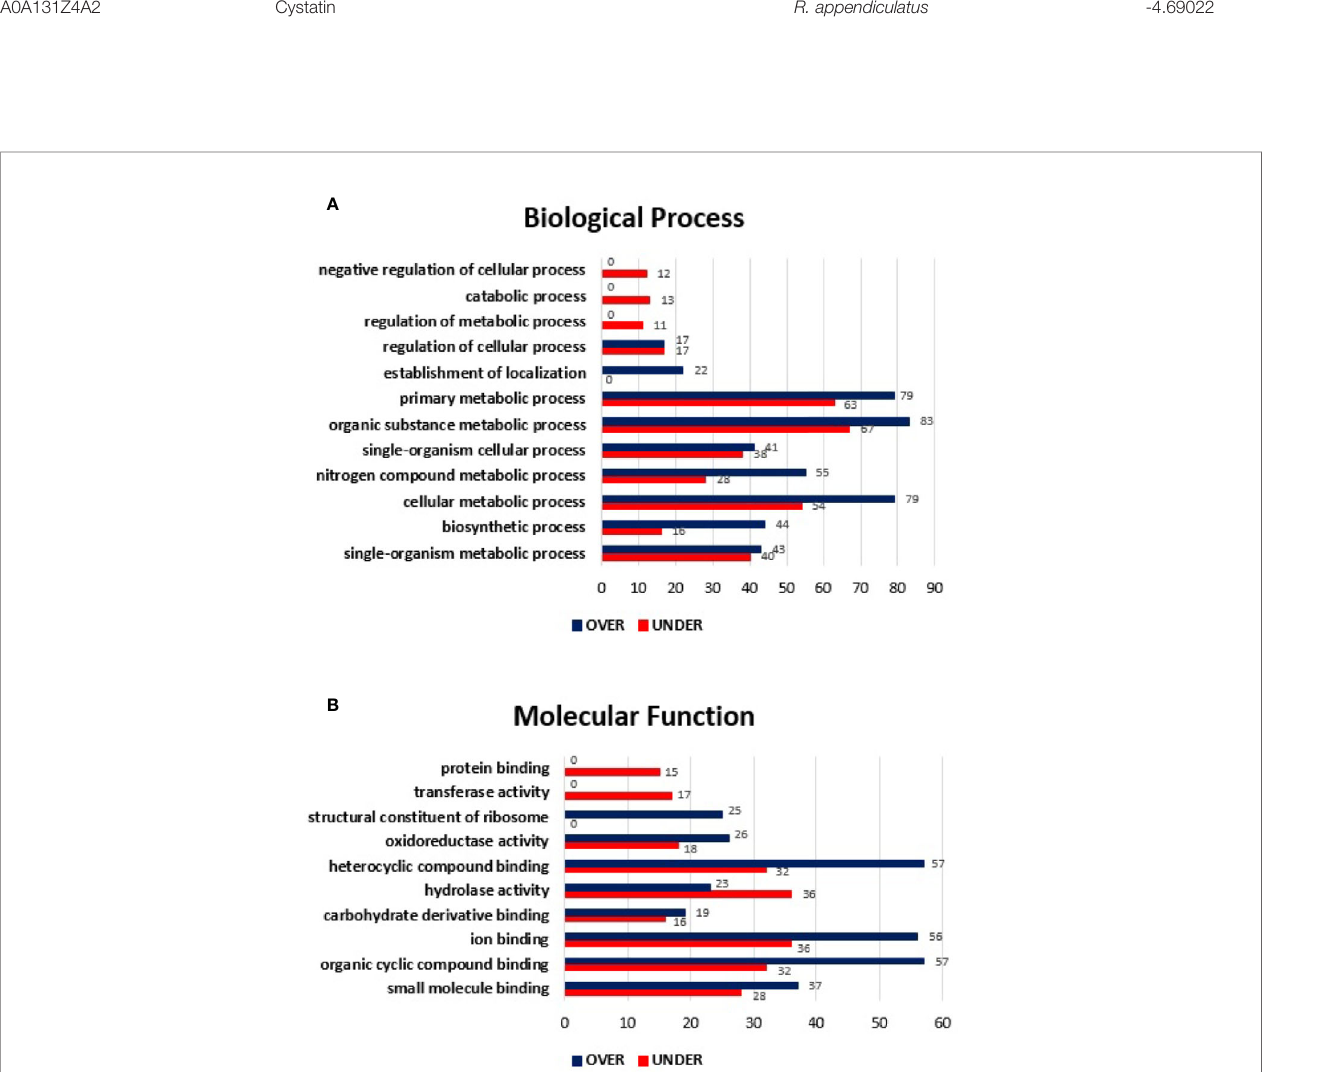
FIGURE 7 | Gene ontology of differentially represented proteins from midgut of R. sanguineus tropical lineage vs. R. sanguineus temperate lineage identi fi ed only in the infection condition. GO terms and its representation of biological process (A) , and molecular function (B) obtained using level 3. Blue bars represent the number of over-represented proteins in the tropical lineage compared to the temperate lineage and red bars represented the number of under-represented proteins in the tropical lineage compared to the temperate lineage (can be interpreted as the number of proteins more represented in the temperate lineage compared to the tropical lineage), with statistical signi fi cance ( p <